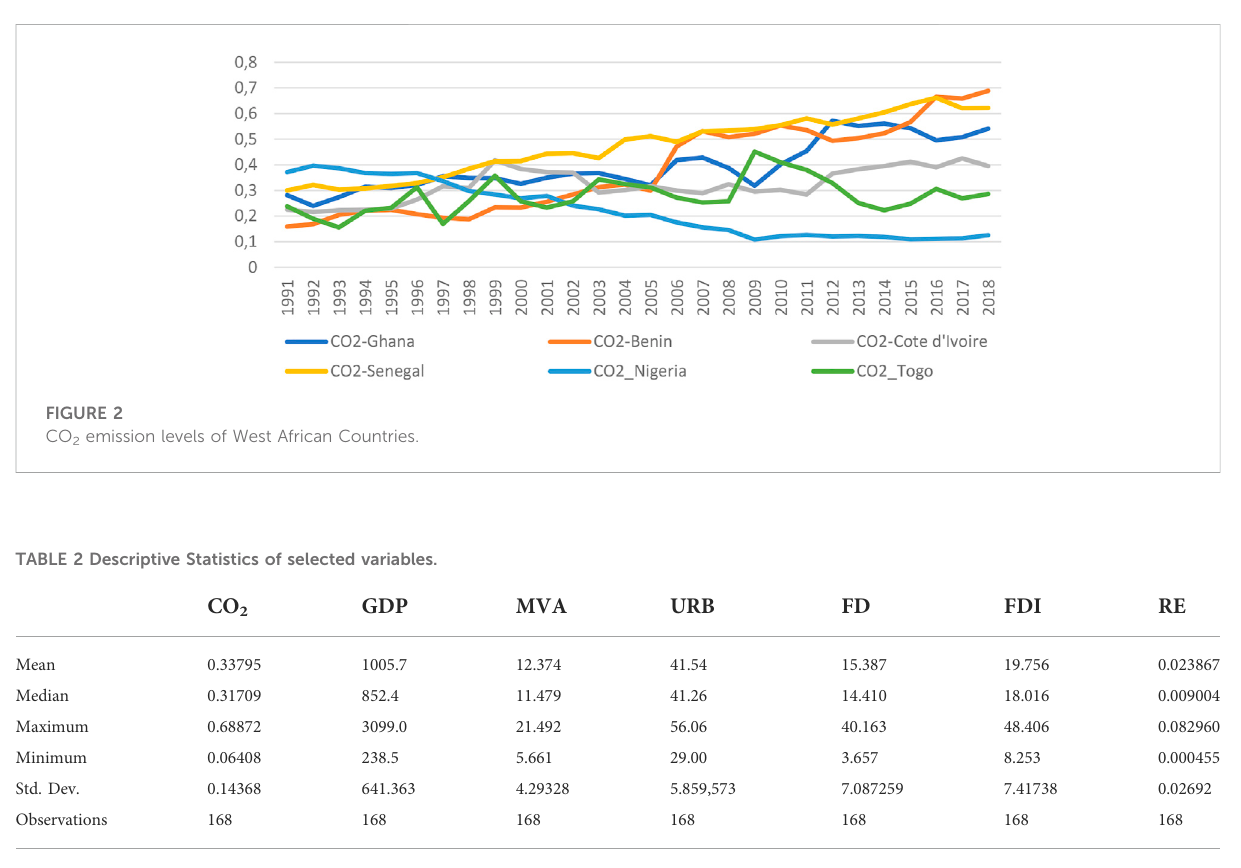
Figure 1). All the variables in this model are transformed into logarithm form to avoid sharpness in the data.